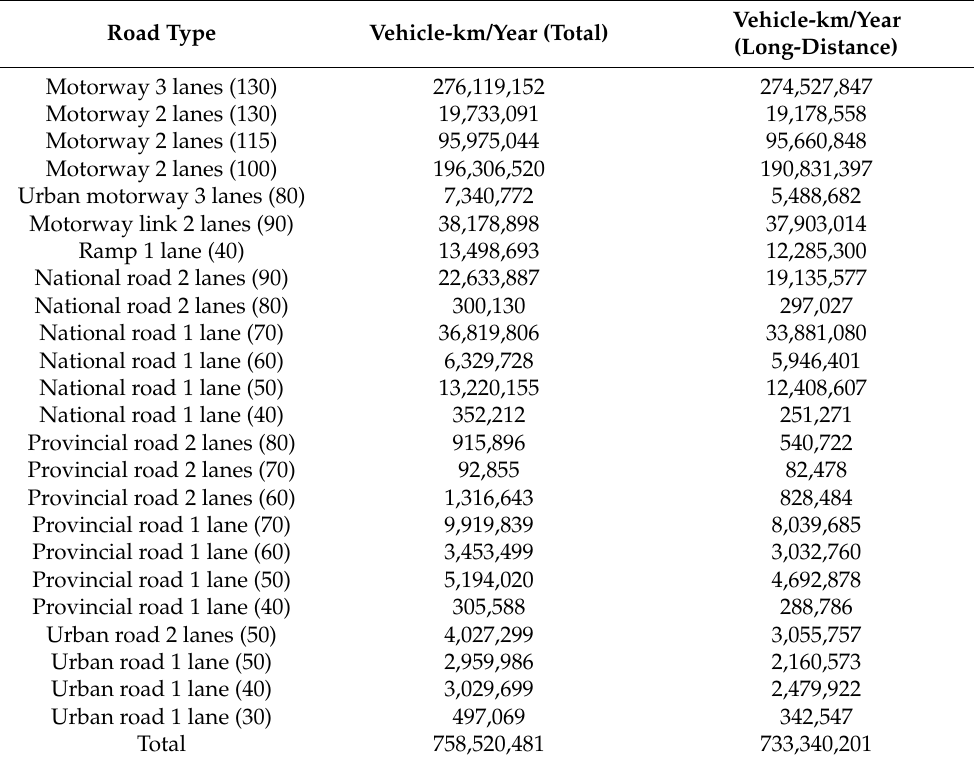
Table 5. Estimated vehicle-km/year [4].